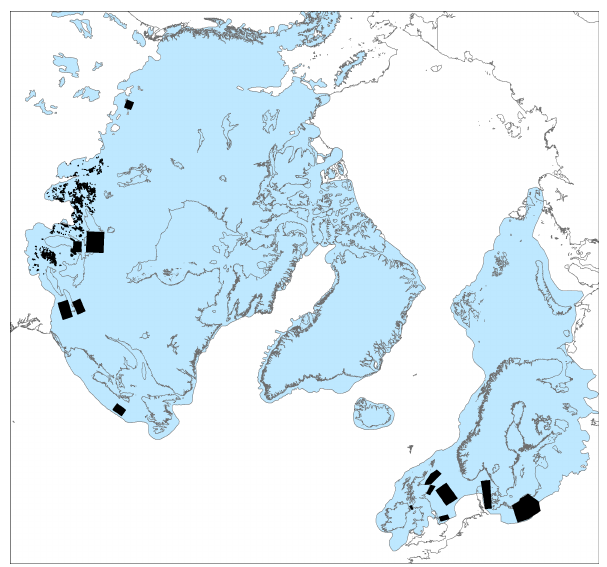
Figure 14. Currently known Northern Hemisphere distribution of tunnel valleys that have been attributed to the last glaciation. The opaque blue shading is the Last Glacial Maximum ice sheet distri- bution. Black lines are the mapped tunnel valleys from Fig. 3 and black boxes are where tunnel valleys have been identified. The pref- erence for tunnel valleys to occur in flat areas close to southern lim- its of the ice sheets is striking, but to what extent does this map cap- ture the true extent of tunnel valleys, perhaps they are selectively unreported from other